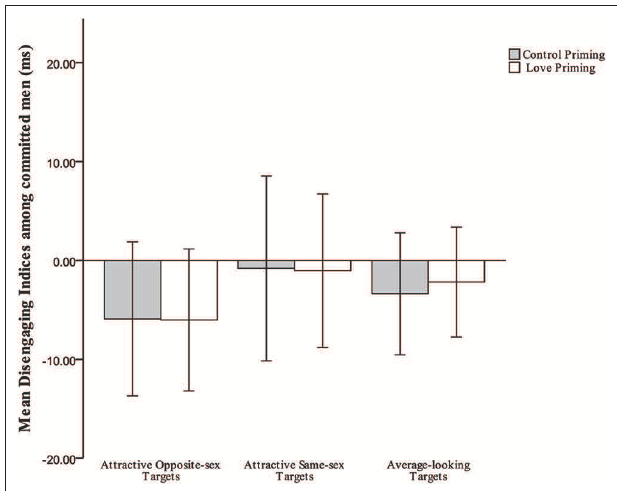
FIGURE 4 | Mean indices of disengagement from all target types for committed men in the love priming and control priming conditions.